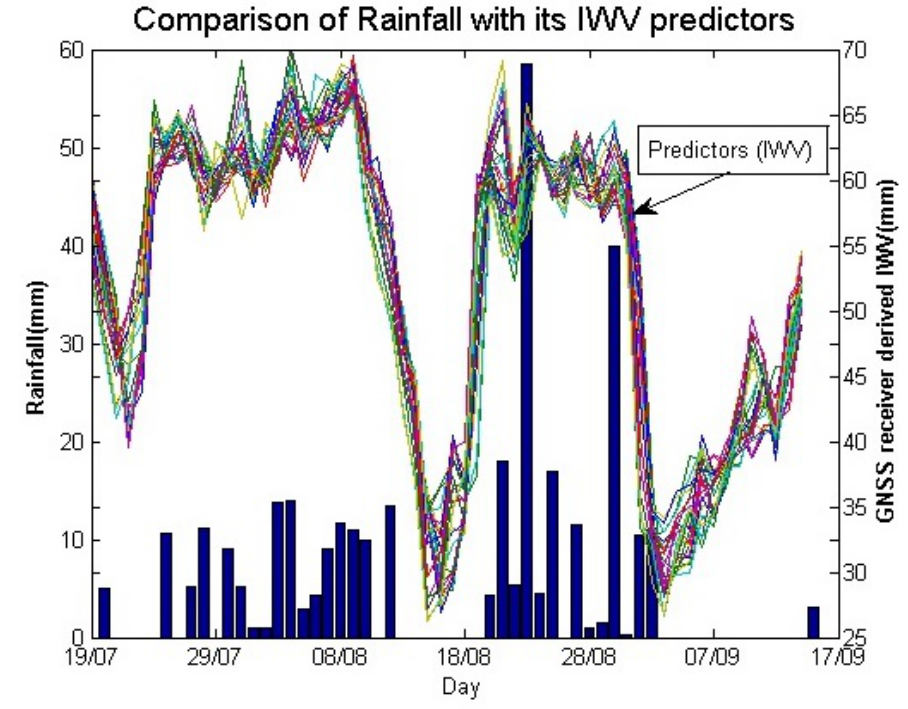
Figure 4. Time-series plot of GPS IWV estimates and rainfall in